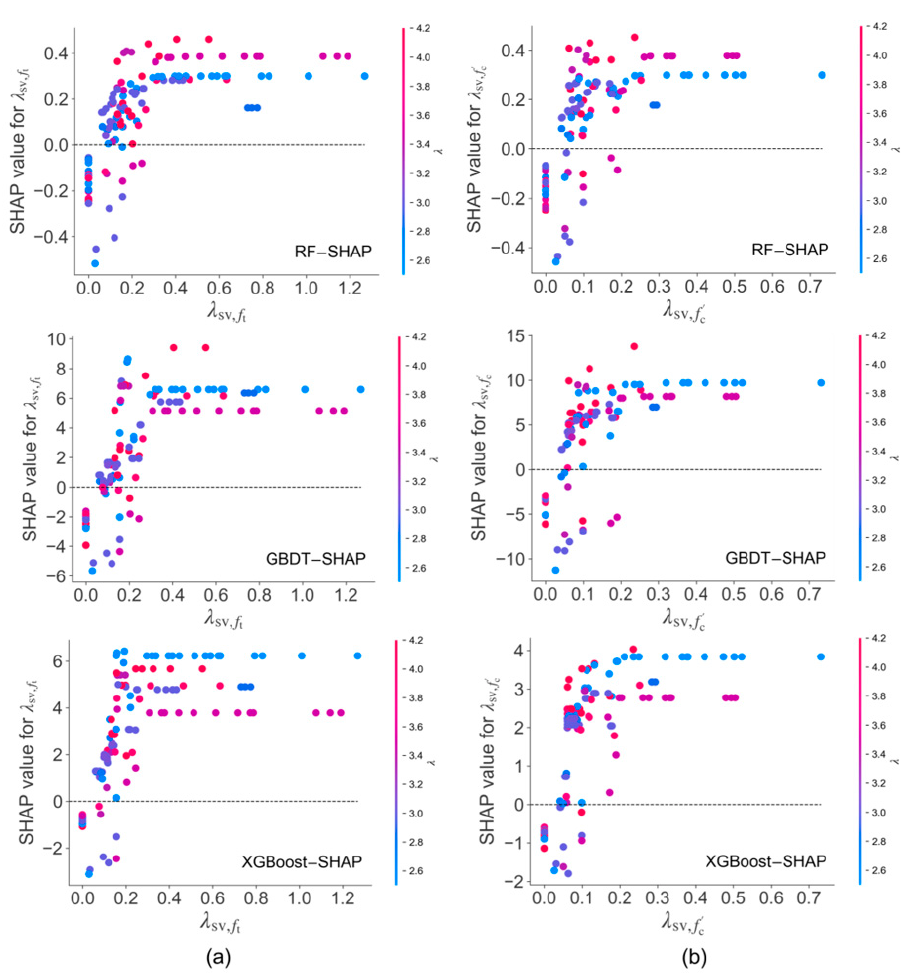
) and ( b ) model 2 (cid:3178) t